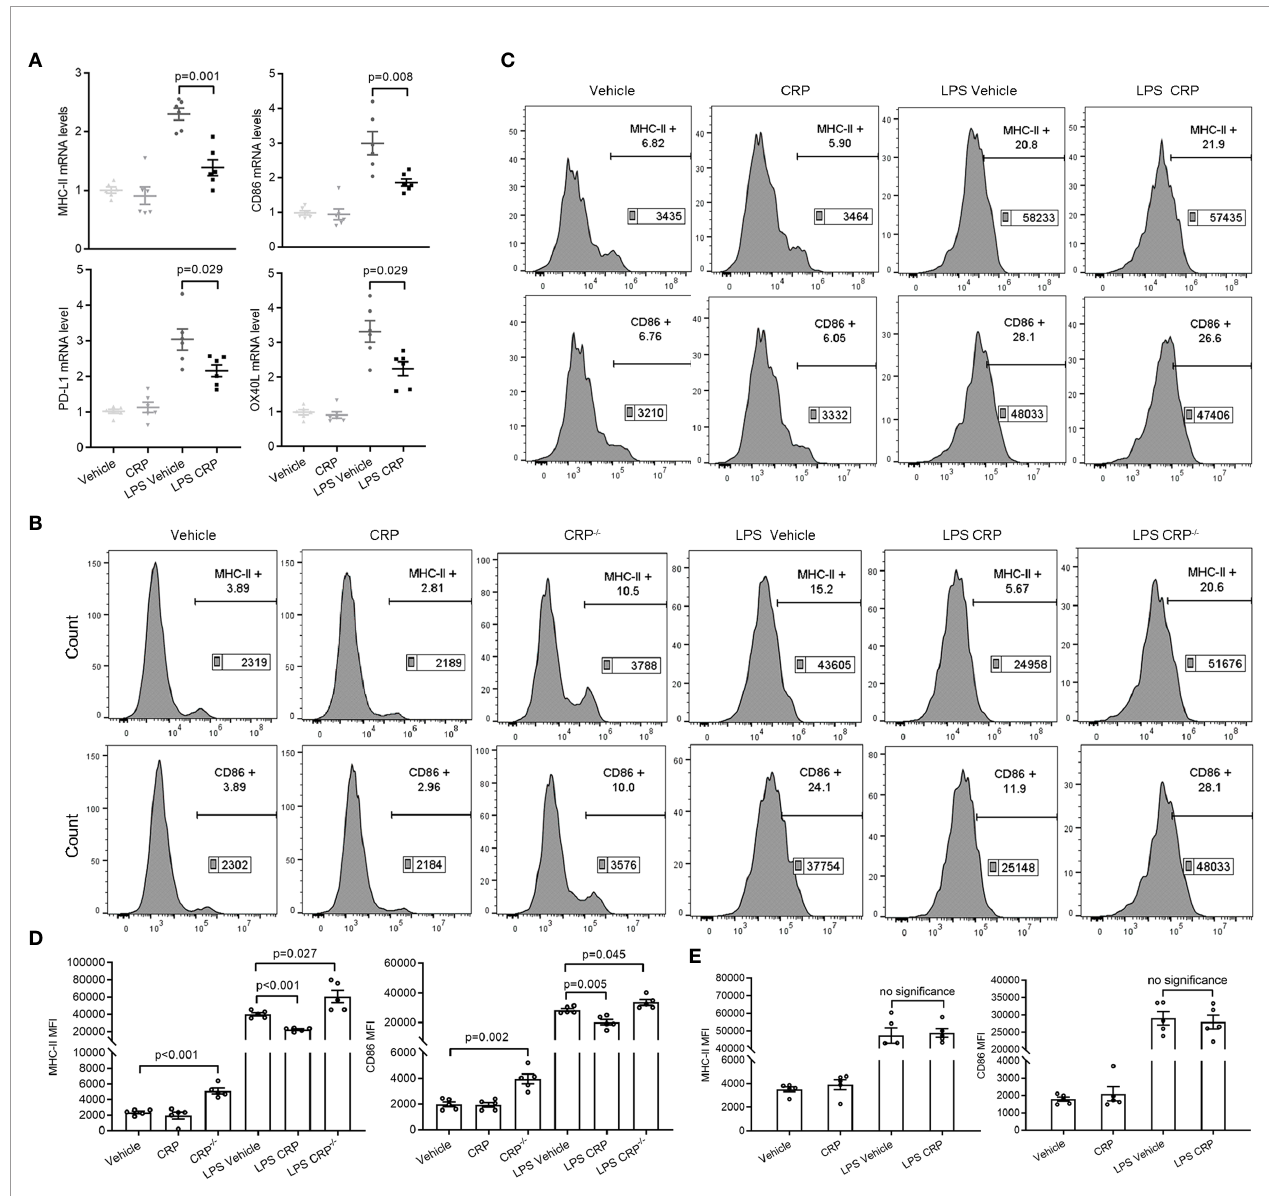
FIGURE 6 | CRP diminishes the antigen presenting ability of moDCs though Fc g R2B. (A) The mRNA expression levels of MHC-II, CD86, PDL-1, and OX40L were measured in LPS and LPS CRP samples from WT moDCs by qPCR (n = 6). (B, D) moDCs were established from WT mice and CRP − / − mice, then incubated with or without CRP and LPS. The expression of MHC-II and CD86 was analyzed by fl ow cytometry and the MFI was recorded (n = 4). (C, E) moDCs were established from Fc g R2B − / − mice and cultured with or without CRP and LPS, then the expression of MHC-II and CD86 was analyzed by fl ow cytometry and the MFI was recorded (n = 4). Data are presented as mean ± SEM; p < 0.05 was considered statistically signi fi cant. ns, no signi fi